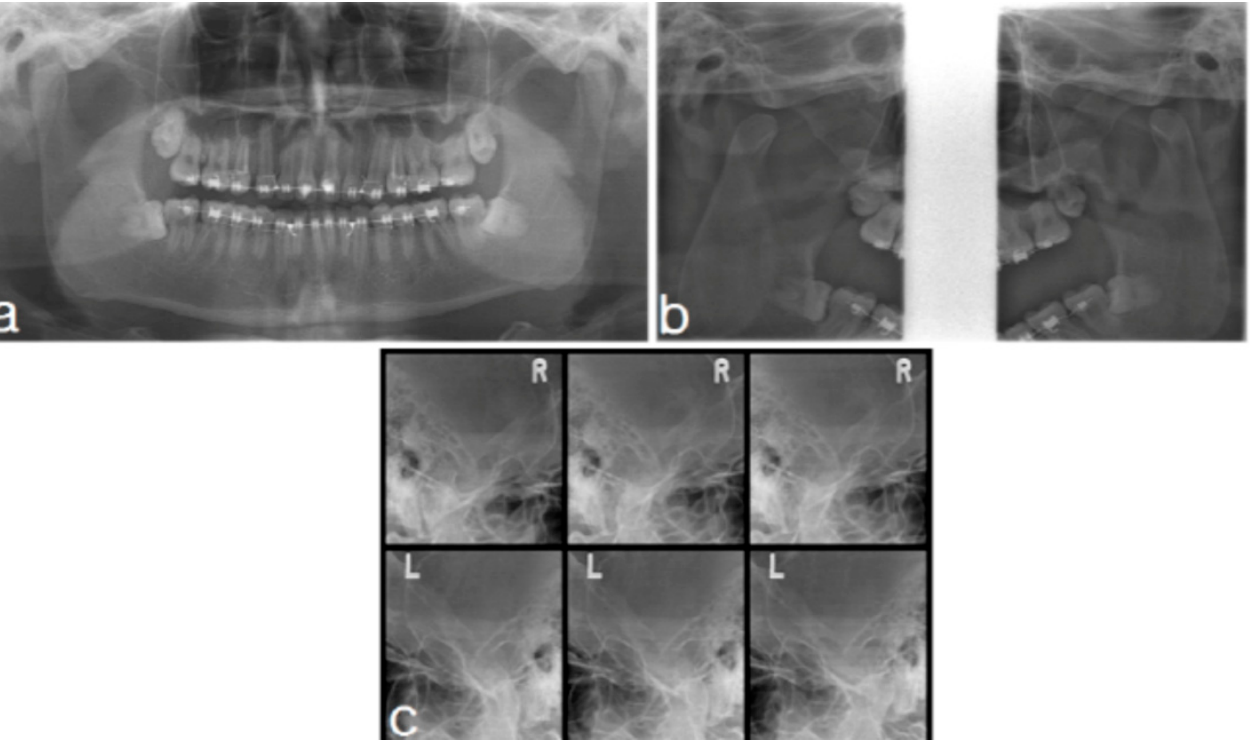
Figure 1. Plain radiographs taken at the first visit. Limited movement of both condyles. ( a ): panoramic view; ( b ): TMJ panoramic view; and ( c ): transcranial view.